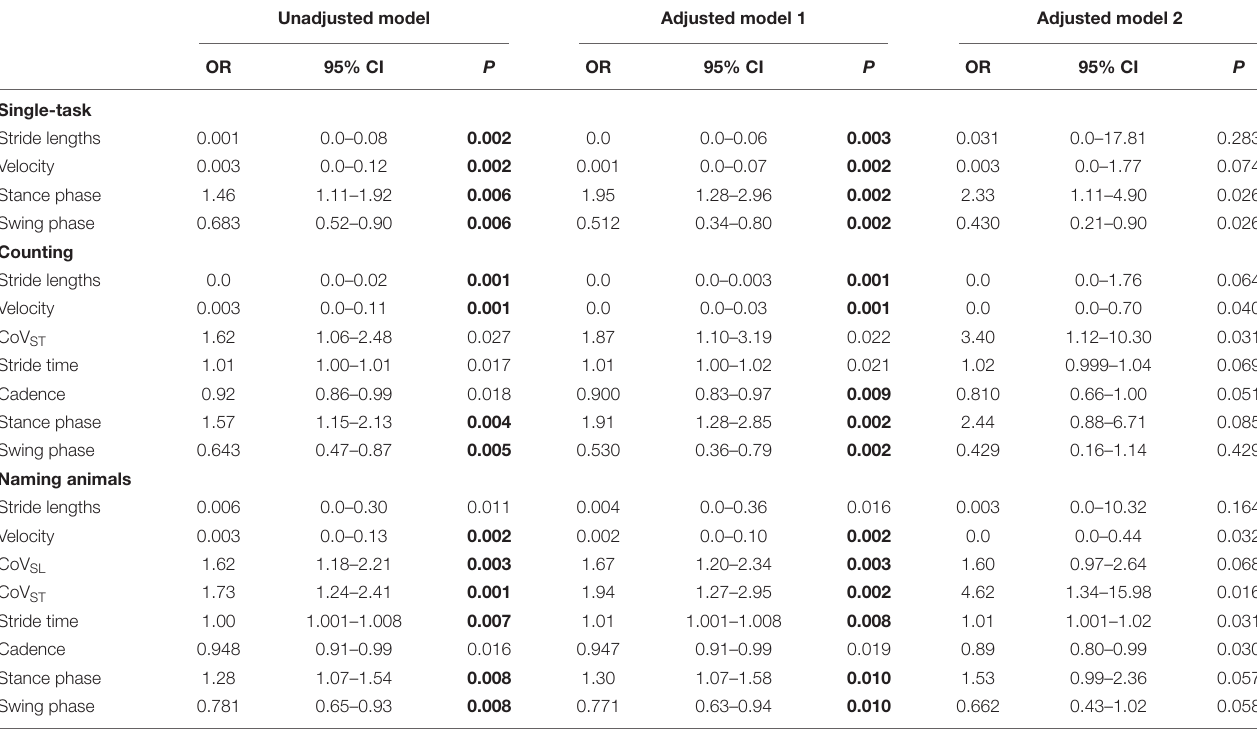
TABLE 4 | Logistic regression of primary gait parameters to identify individuals with PSD from individuals with PSCN.